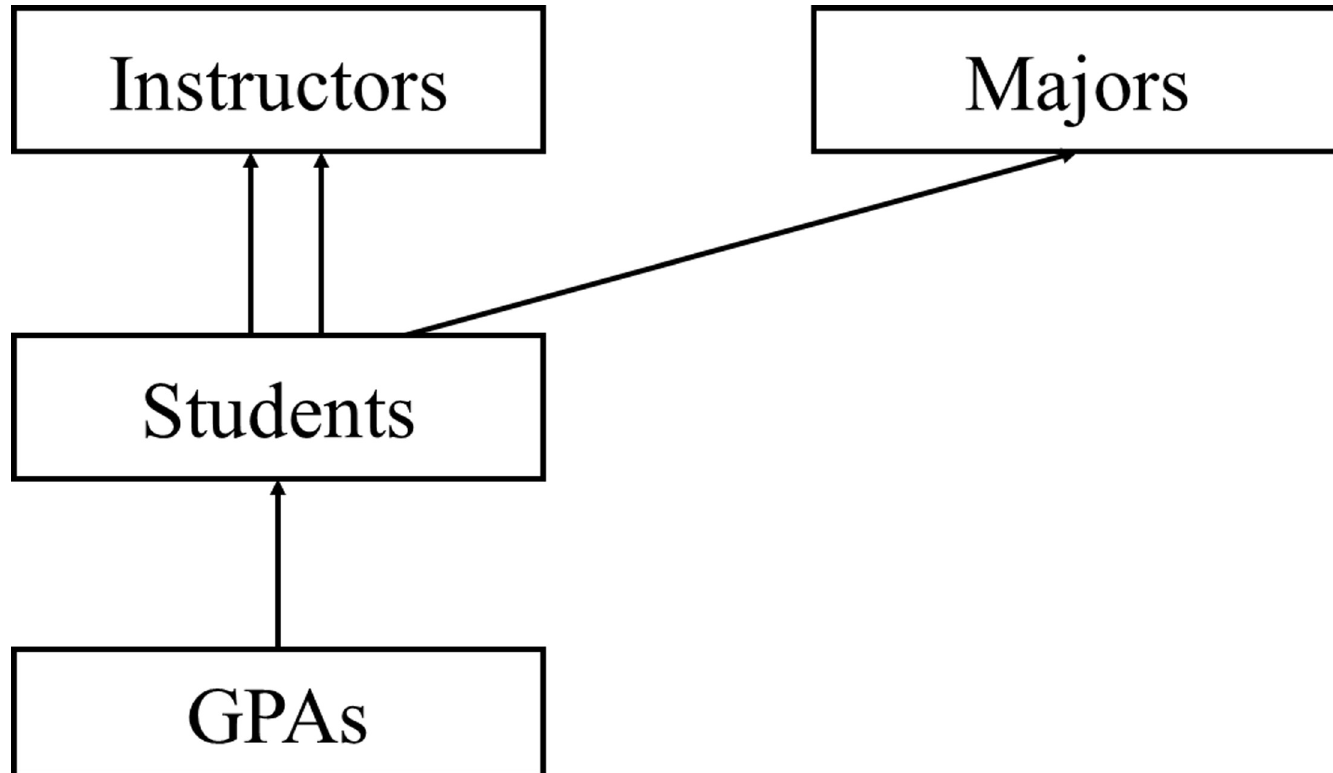
Fig 1. Multiple membership multiple classification GPAs, students, majors, and instructors.